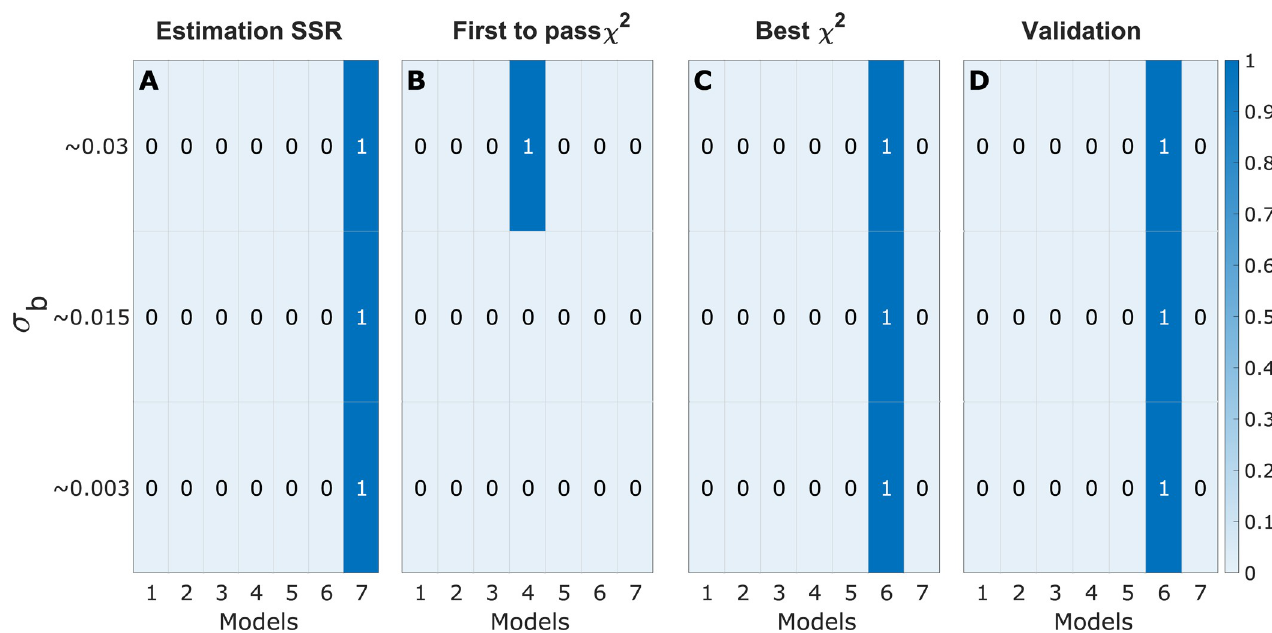
Fig 12. Model selection results for the cultures epithelial cell example. (A–D) Heatmaps represent results from the indicated selection methods, where rows represent different values of σ b and columns represent the MFA models M the given σ b , out of 1000 samples, as indicated by the color scale (right).